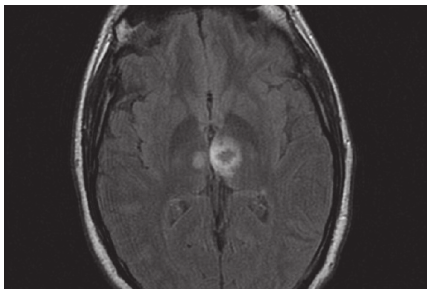
Figure 2: Magnetic resonance imaging where a bilateral acute thalamic infarction compatible with Percheron syndrome is ob- served appreciating hemorrhagic transformation in the left thalamus.